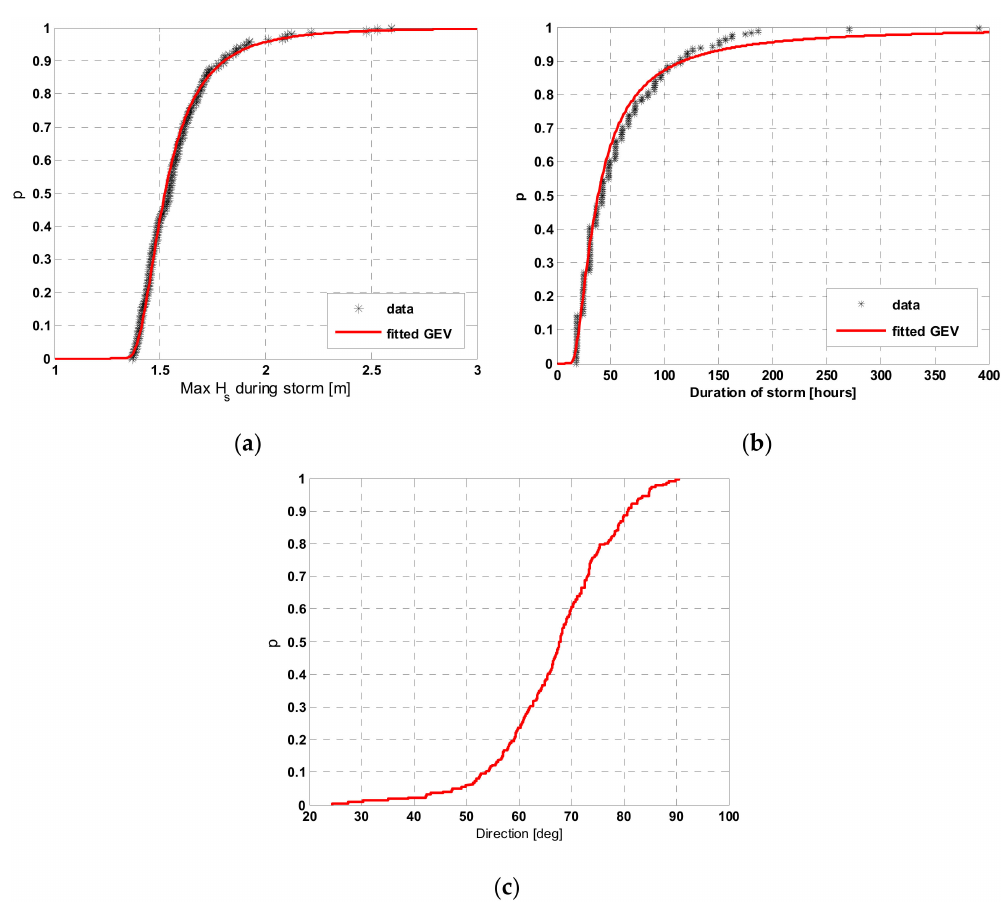
Figure 9. Cumulative distribution function and fitted GEV of maximum significant wave height (H s ) ( a ), storm duration ( b ), and Empirical cumulative distribution function of average wave direction ( c ) during 30 years of storms at Dutch Bay (Cell